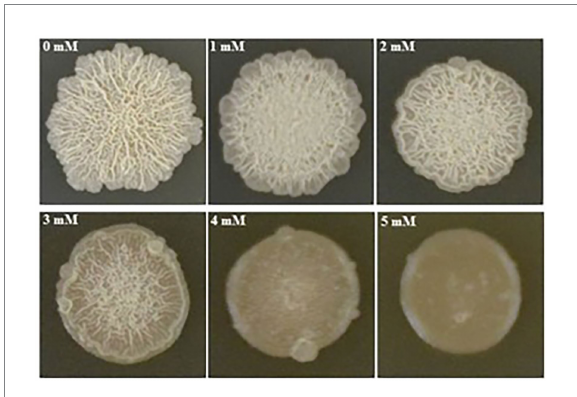
FIGURE 1 Impacts of Cd2 + on the biofilm colonies of B. subtilis 1JN2. 5 ul of 1JN2 suspension (10 6 CFU/ml) was spotted on the surface of LBGM agar plate with a Cd2 + gradient of 0, 1, 2, 3, 4 and 5 mM, the picture was taken at 72 h post incubation at 30 ° C.